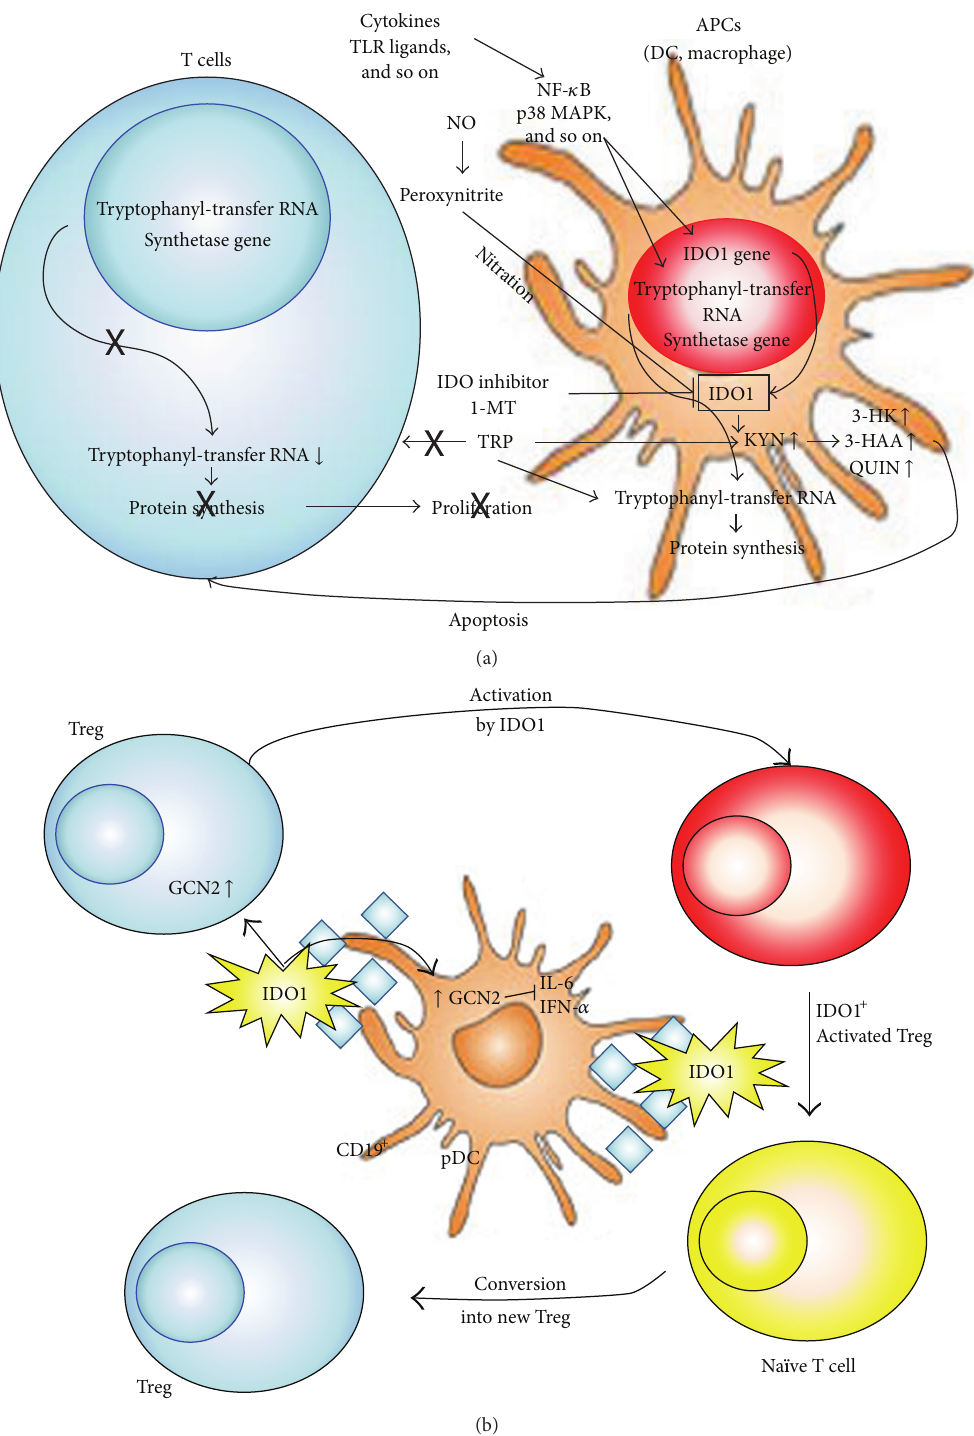
Figure 2: T-cell immune regulation by IDO1. (a) IDO1 is induced by IFN- 𝛾 -dependent and/or -independent signal pathways, depending on the variety of immune stimuli by macrophages and dendritic cells (DCs) [28, 83]. IDO1 activity is suppressed by the formation of NO or the competitive enzyme inhibitor, 1MT. Marked increases in IDO1 suppress immune responses by locally depleting L-TRP and preventing T-cell proliferation [44]. Expression of IDO1 has been observed in certain types of activated macrophages and DCs. IDO1-expressing cells deplete TRP from the extracellular milieu and secrete TRP metabolites, including KYN, 3-HK, 3-HAA, and QUIN, which induce T-cell apoptosis and suppress immune responses in vitro . (b) CD19 + plasmacytoid DCs (pDCs) express high levels of IDO1, which can activate mature regulatory T (Treg) cells via activation of the protein kinase general control nonderepressing-2 (GCN2) pathway of protein synthesis inhibition [84]. pDC- produced IDO1 and activated Treg can convert na¨ıve T cells into new Treg. IDO1 acts in an autocrine manner to suppress pDC production of IL-6, which prevents the conversion of Treg into IL-17-producing Th17 proinflammatory cells [79]. IDO1 also downregulates type I IFN (IFN- 𝛼 ) production by pDC